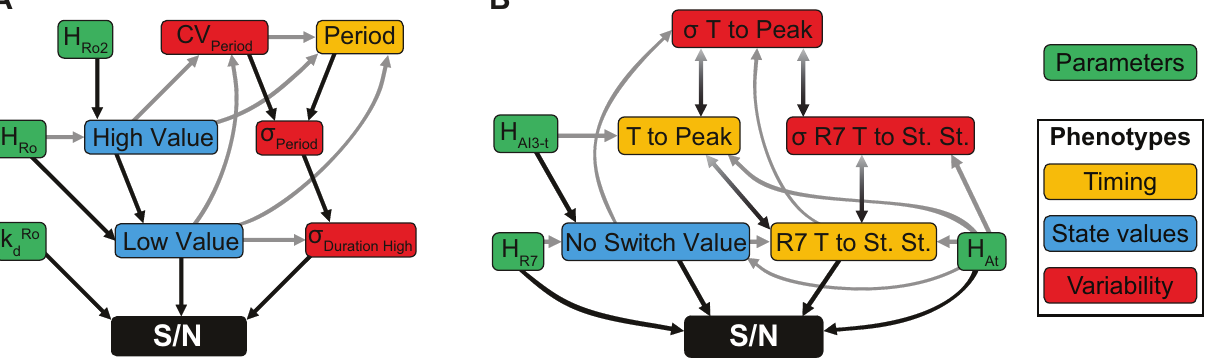
Figure 9. Bayesian networks of the impact of synthetic heterogeneity module phenotypes and rate constants on system performance value (S/N). (A) Bayesian network inference using oscillator rate constants and phenotypes. (B) Bayesian network inference using throttle rate constants and phenotypes. Black arrows indicate the most direct connections between a node and S/N. The Bayesian inference describes phenotype groupings relevant to state values (blue), timing (yellow), and variability (red), along with the rate constants that control these phenotypes (green).